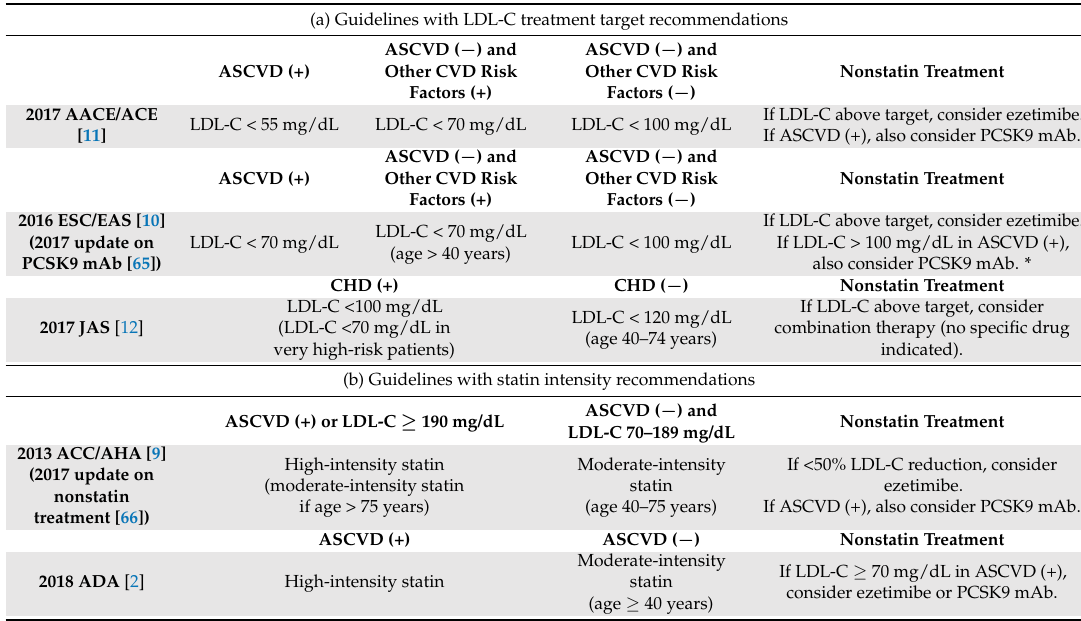
Table 2. Recommendations for treatment of dyslipidemia in patients with